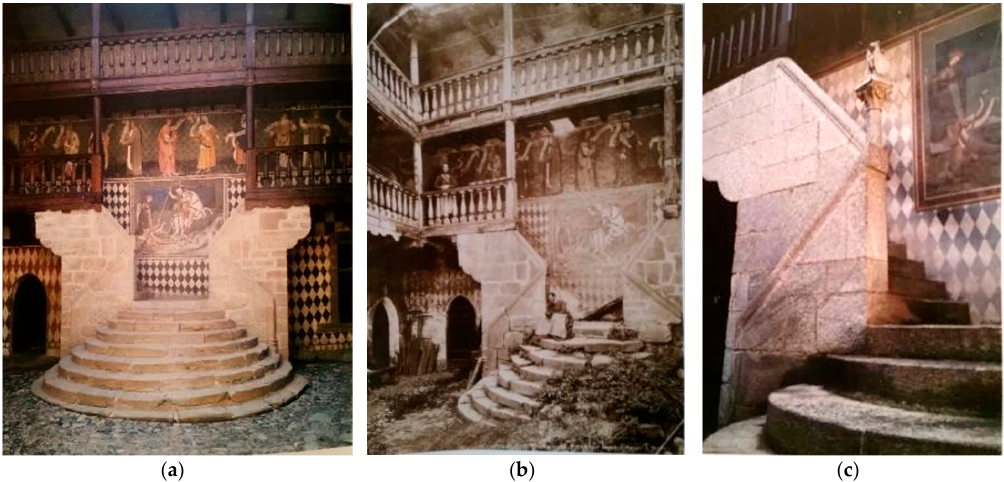
Figure 2. The main staircase in the courtyard of ( a ) the Fenis Castle (AO) in 2004 and ( b ) back to 1884